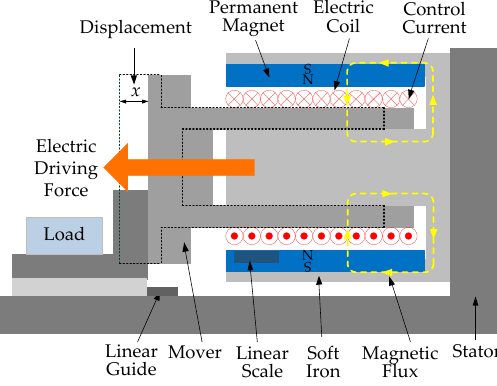
Figure 1. Structure of a voice coil motor (VCM).